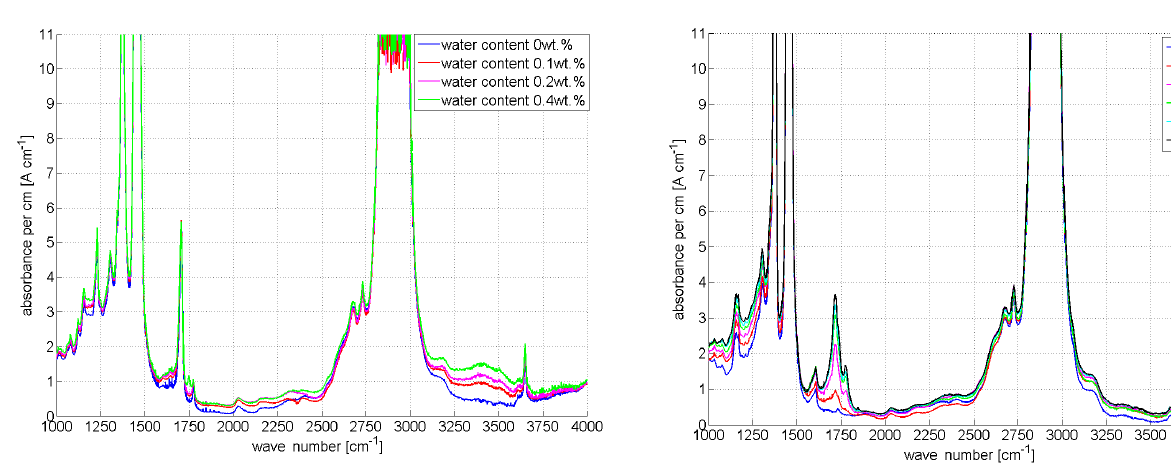
Figure 5. IR spectra of synthetic motor oil with added water (ASTM type II, 0, 0.1, 0.2 and 0.4wt.%, respectively). to the results observed for the artificially aged synthetic oil.